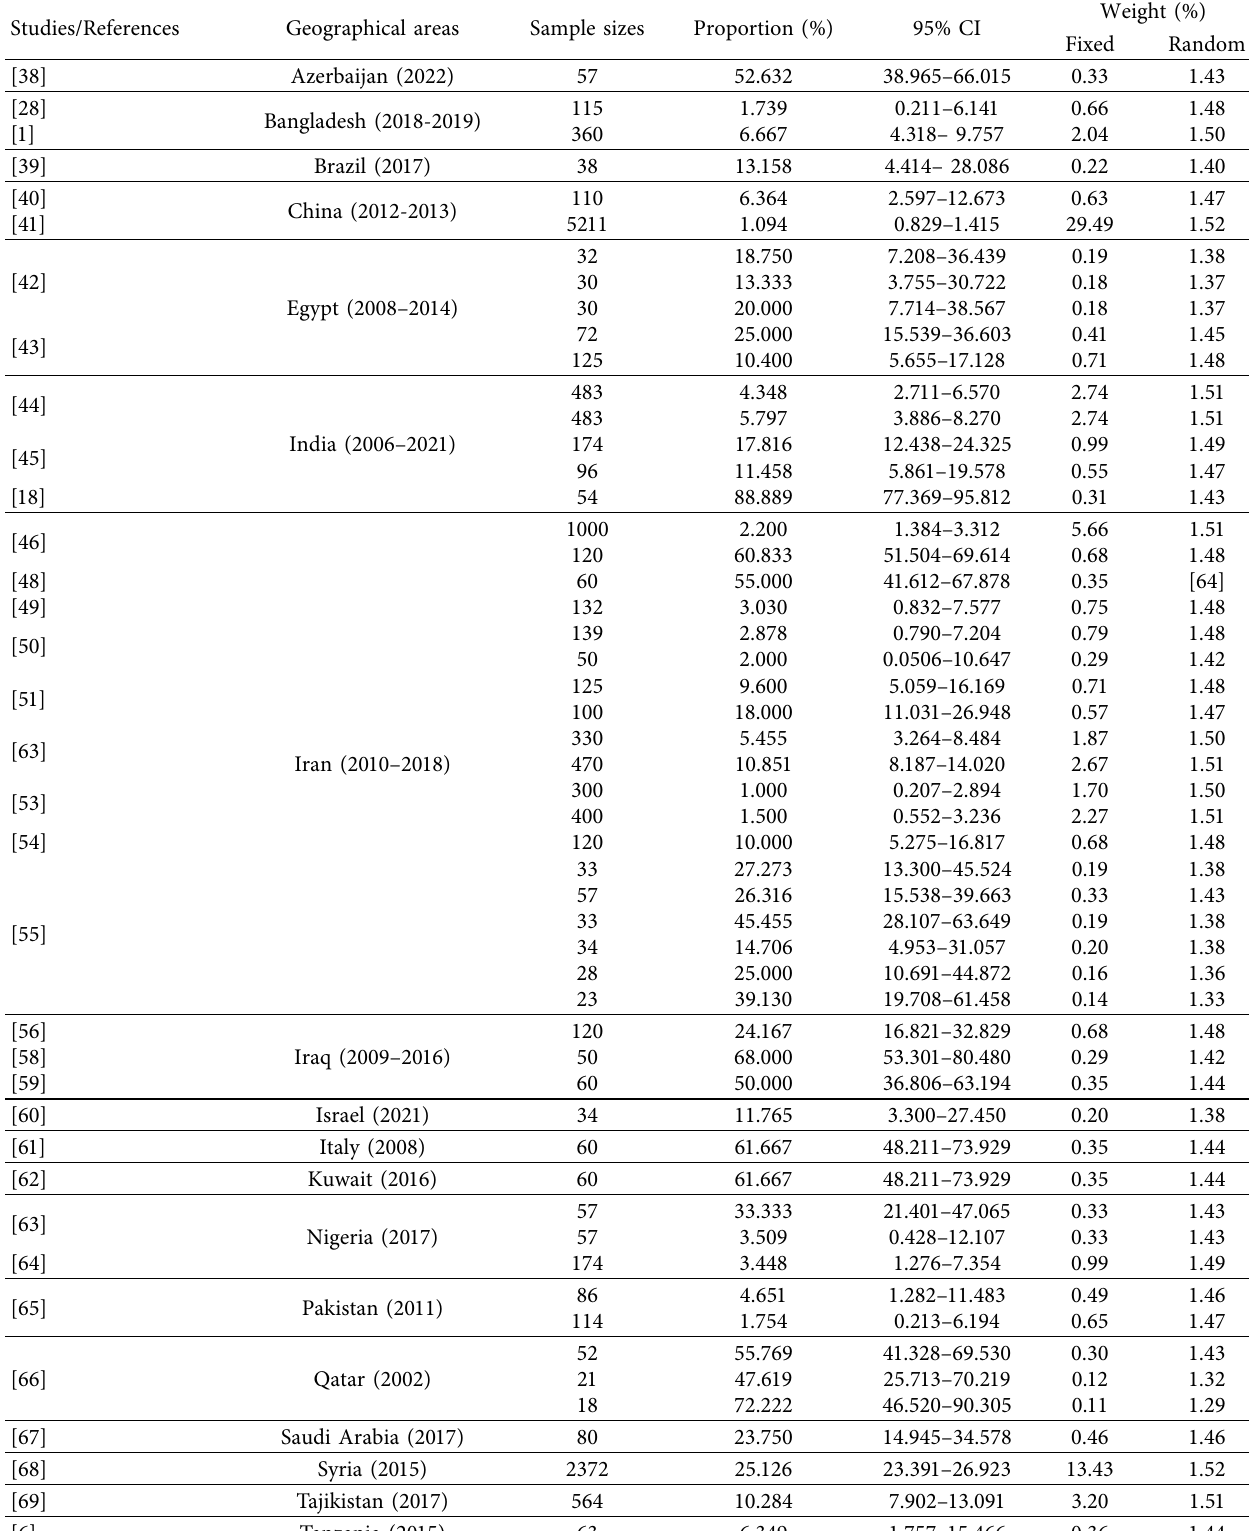
Table 2: Meta-analysis proportion for the prevalence of brucellosis in milk and dairy